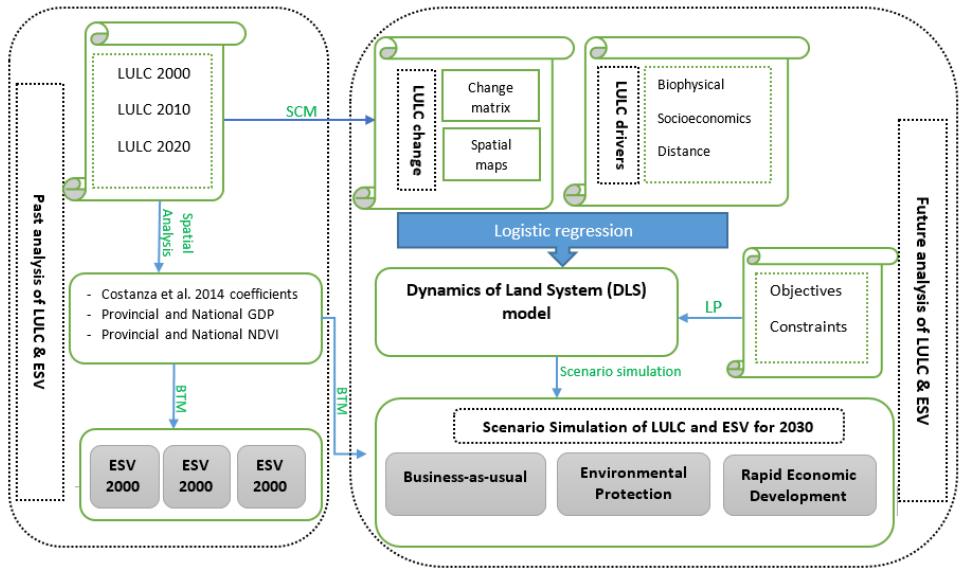
Figure 1. Schematic diagram of the study work.